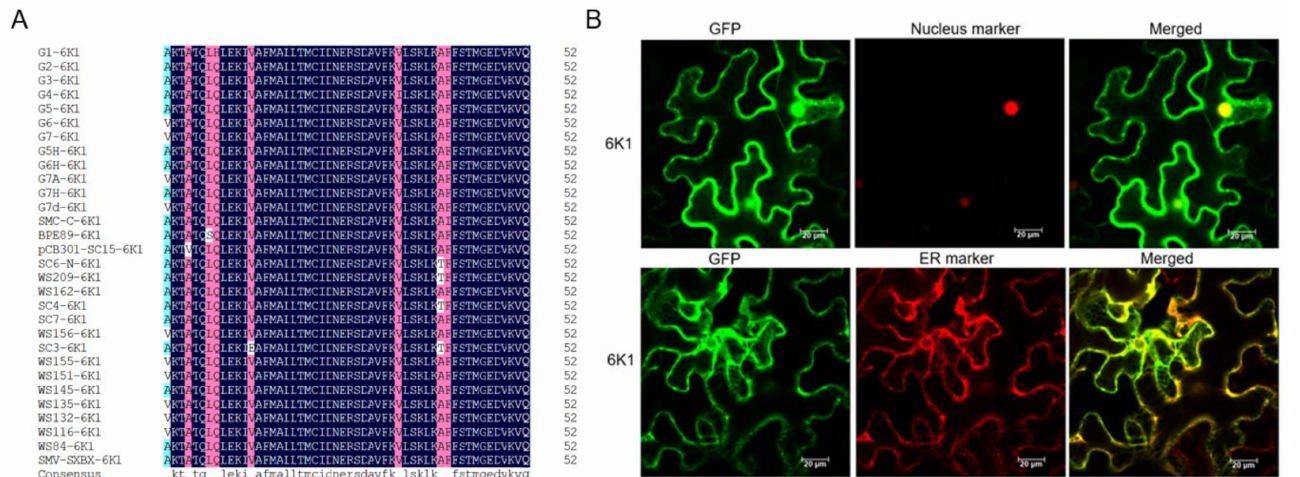
Figure 1. Sequence alignment and subcellular localization of SMV-6K1. ( A ) A multiple sequence align- ment of 6K1 protein sequences of 30 SMV isolates. The sequences of 30 SMV isolates were retrieved from the NCBI database and the accession numbers are shown: G1 (FJ640977.1), G2 (S42280.1), G3